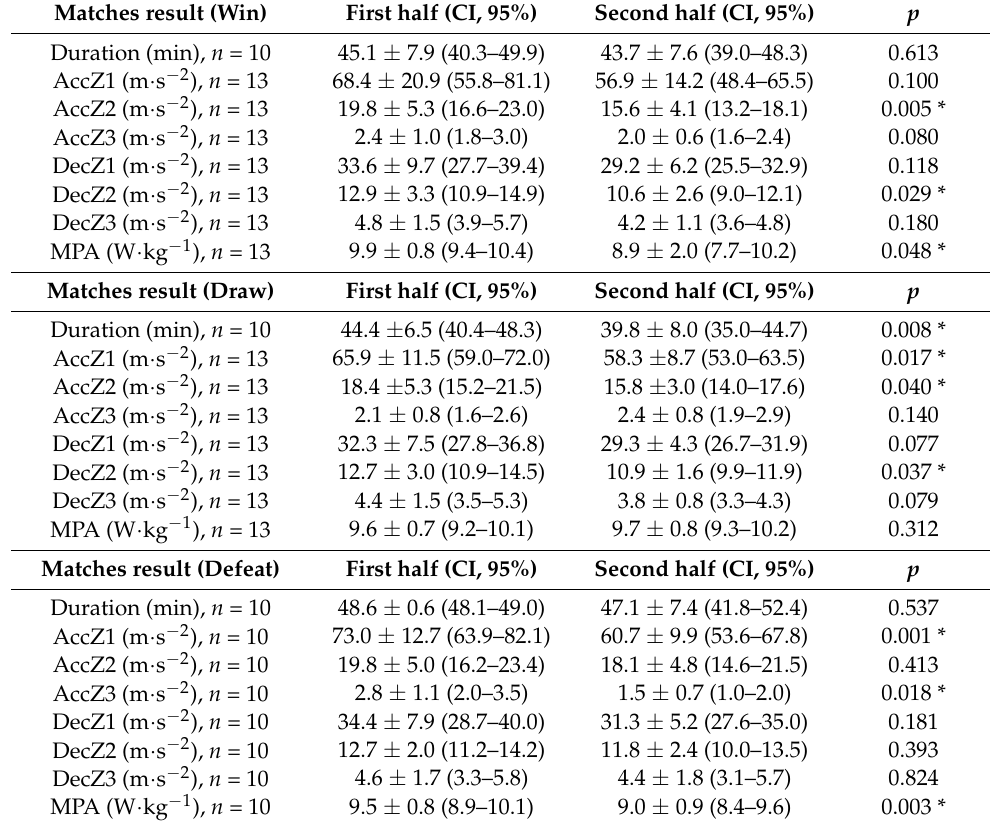
Table 3. Comparison of first and second halves data for the matches won, drawn, and defeated per squad average, mean ± standard deviation (confidence interval, CI,